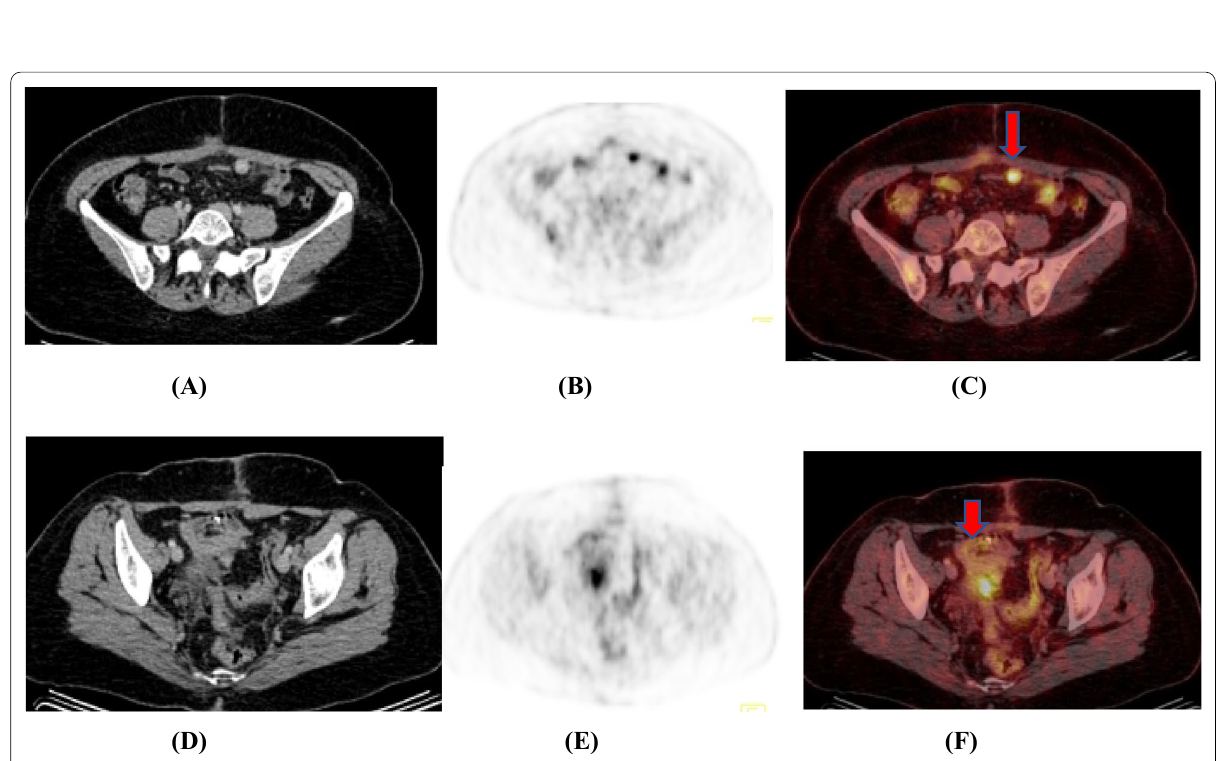
Fig. 5 The 2nd PET/CT follow‑up study A – C Axial CT, PET and PET/CT scan showing small peritoneal deposit nodule residual at LV5 level measured up to 1.2 with SUVmax 9.5. D – F Axial CT, PET and PET/CT scan showing residual minimal omento‑peritoneal infiltrative thickening is seen beneath = anerior abdominal SUVmax 8.4 with successful total excision of the previously detected left complex neoplastic adnexal mass =